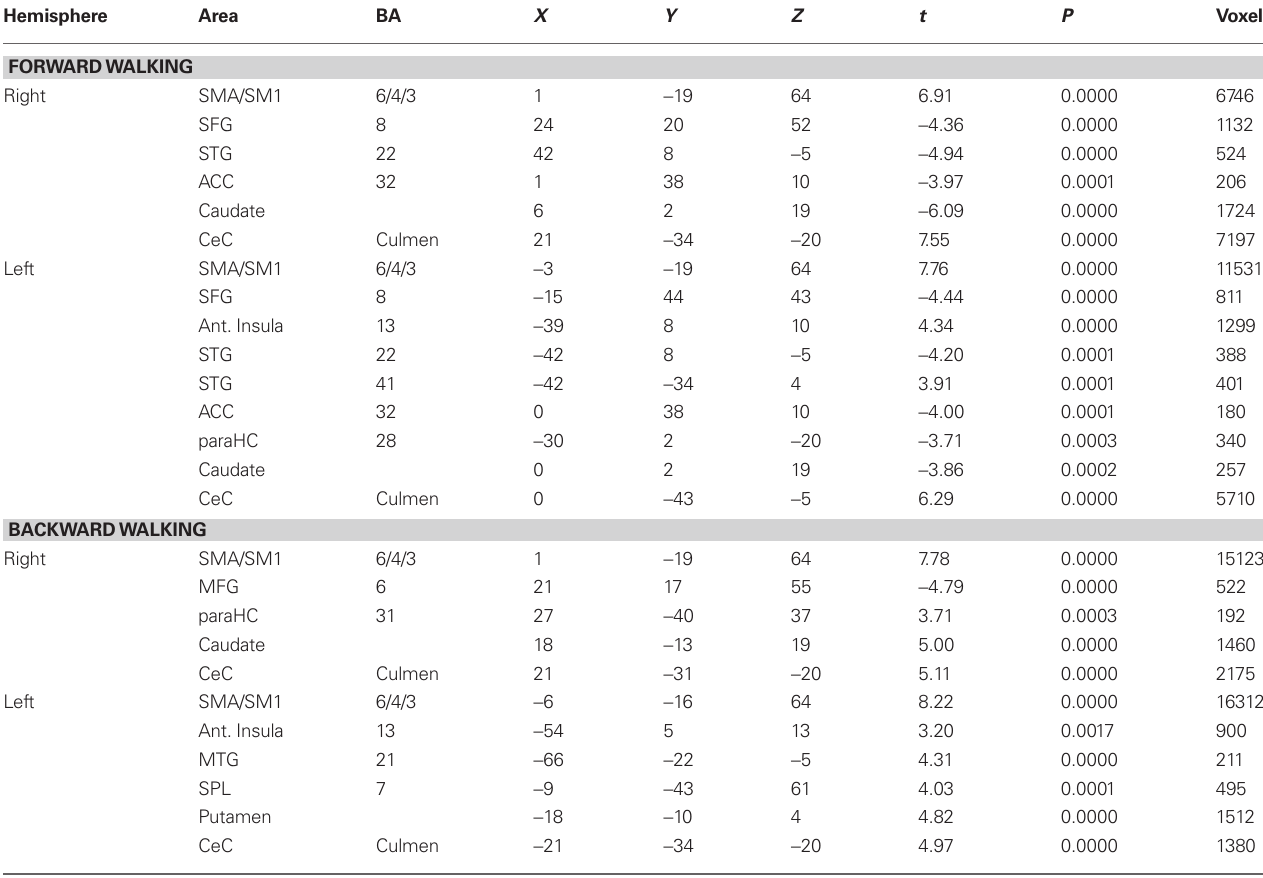
Table 2 | Talairach coordinates, t - and P -values, and voxel numbers of significant regions of interest for imagination of forward and backward walking. Hemisphere